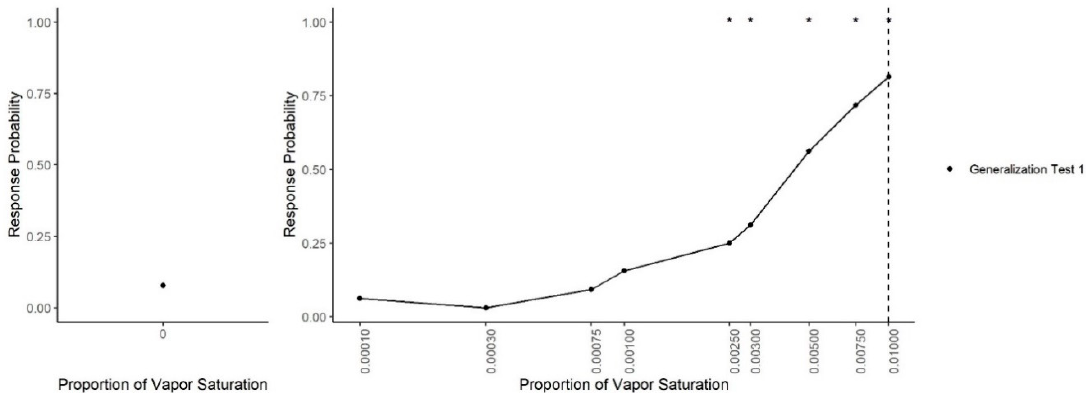
Figure 3. Generalization Test 1. The spontaneous generalization to a range of air dilutions of the trained odorant (0.01; dashed line): ( Left ) the response to a clean air stimulus; and ( Right ) the range of concentrations on a log scale. * indicates the probability of response was greater than the probability of response to the clean stimulus p < 0.05.